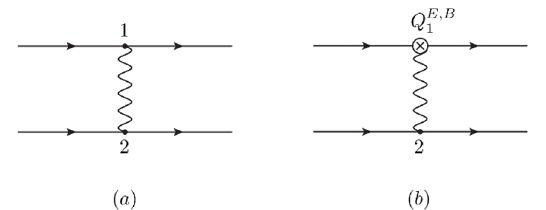
Figure 1 . Potential exchange diagrams that contribute to the two-particle action S int . In (a) the particles interact through the minimal gravitational interaction. Figure (b) is the term in S int generated by the quadrupole couplings of particle 1 (a similar diagram with 1 $ 2 has been